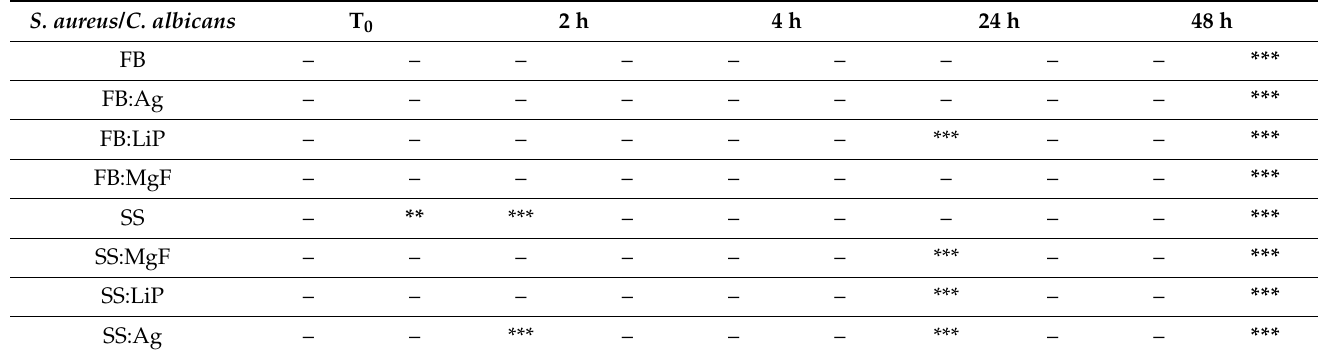
In the case of the P. aeruginosa strain, at T 0 , similar colonization values were obtained for all tested materials (Table 4, Figure S6). After 2 h, although a slight decrease in the logCFU/mL was noticed, the results were not statistically significant. After 4 h of incubation, all tested materials significantly decreased the levels of P. aeruginosa as compared to the control Ti (Table 4, Figure S6). The FB and FB:Ag thin films significantly inhibited the growth of P. aeruginosa after 24 h of incubation (a 3–4 log reduction as compared to the control Ti: Table 4, Figure S6). After 48 h of incubation, all of the tested materials indicated a lower degree of colonization with P. aeruginosa , but statistically significant values were recorded only in the case of FB:Ag, FB:LiP, FB:MgF, SS:MgF, and SS:Ag thin films (Table 4, Figure S6). In the case of Gram-positive strains, less competitive behavior was recorded in the tested materials in comparison with the Gram-negative ones. For the S. aureus strain (Table 5, Figure S7), at T 0 and at 2 and 4 h, similar levels of colonization were obtained for all tested materials. Table 5. Representation of the statistically significant inhibitory effect exhibited by different samples against the Gram-positive (i.e., S. aureus) and fungal (i.e., C. albicans) (in bold ) strains’ adherence